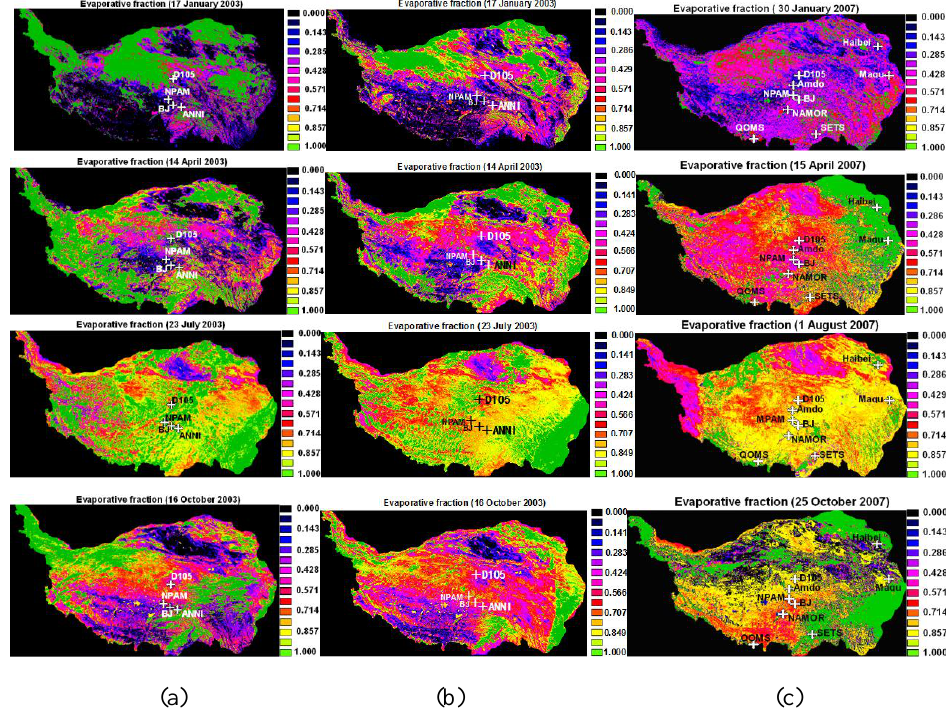
Fig. 3. The distribution maps of evaporative fraction ( 3 ) over the Tibetan Plateau area (73.5–107.1 ◦ E, 25.0–40.1 ◦ N). (a) AVHRR-2003; (b) MODIS-2003; (c) Fig.3 The distribution maps of evaporative fraction ( Λ ) over the Tibetan Plateau area